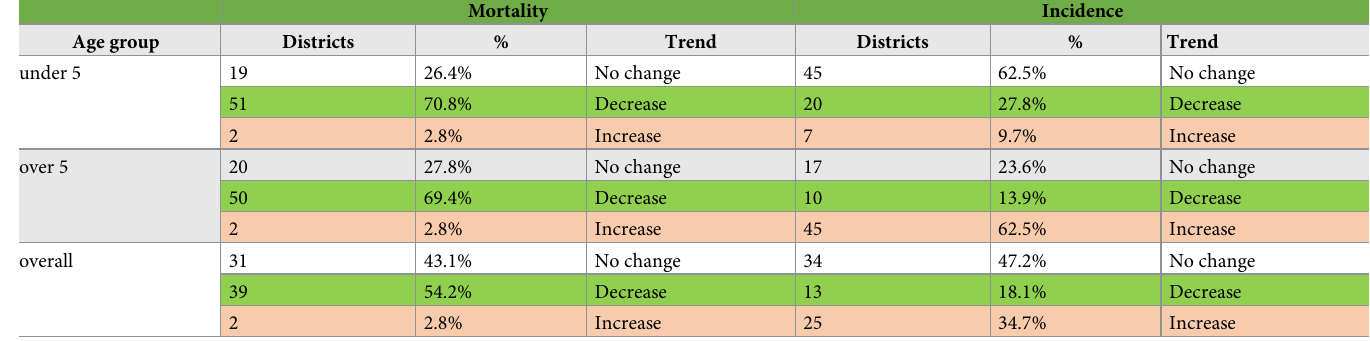
Table 1. Summary description of malaria mortality and incidence trends ( < 5 years children, � 5 years, and all ages combined. NB % represents the proportion of the 72 districts assigned to each trend , i . e . Decrease , Increase , or No-change